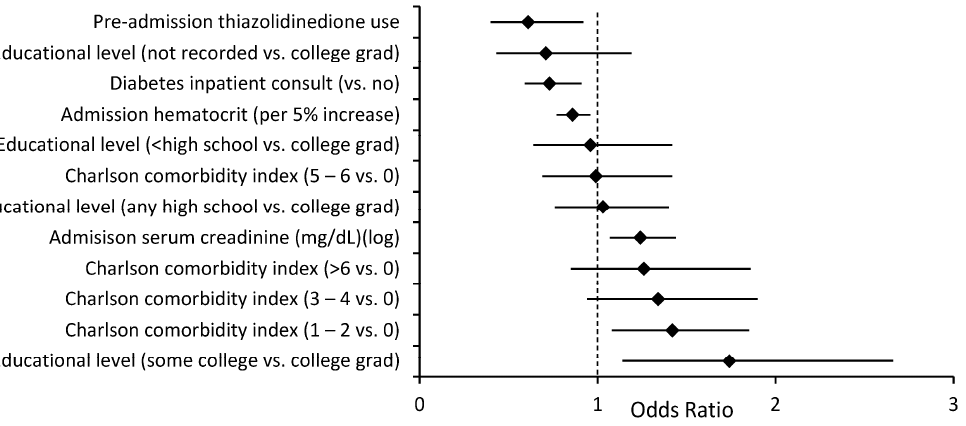
Figure 3. Risk factors for readmission unique to primary discharge diagnosis of diabetes, OR (95% CI). (cid:7) = Odds ratio.